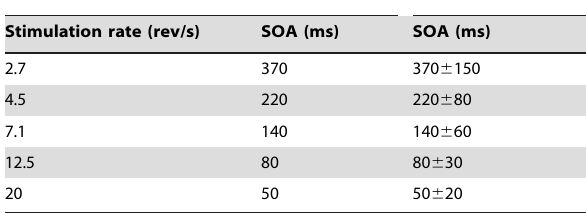
Figure 1. Stimulation design. ‘On’ and ‘off’ sequences were alternatively presented. ‘On’ sequences consisted of checkerboard reversal sweeps of 22 stimuli. The stimulus onset asynchrony (SOA) between pattern reversals was either constant (isochronic conditions) or variable (jitter conditions). The presentation of isochronic and jittered sequences at different rates was randomized. ‘Off’ sequences consisted of grey stimuli lasting 2 to 5 seconds. Note: checkerboards comprised 8 by 8 checks; the figure shows 2 by 2 checks for illustrative purposes.